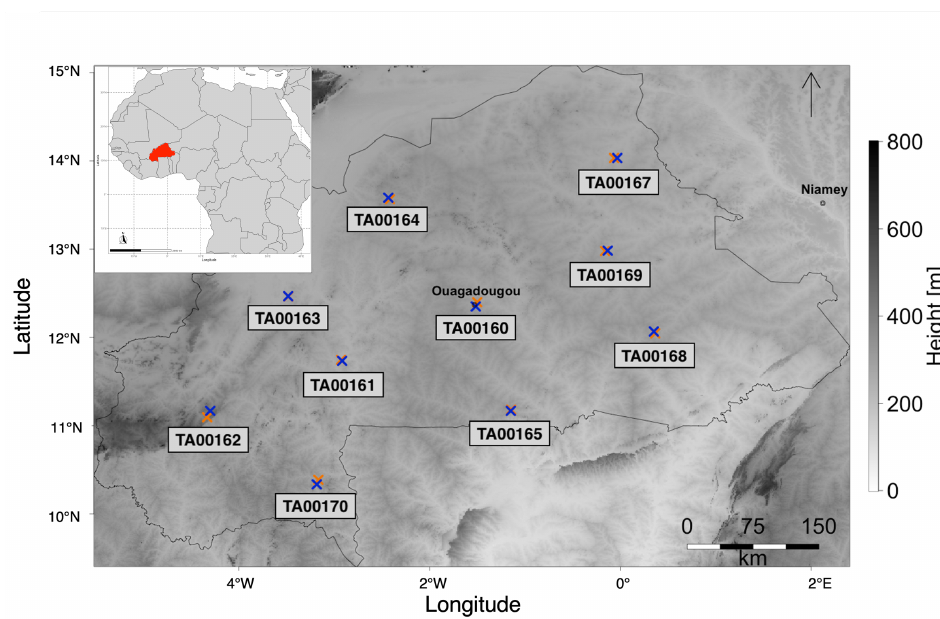
Figure 2. Topographic map from Burkina Faso with the examined stations and the TAHMO station name (for MET station name see Table 1). Stations from the Burkina Faso meteorological service are in blue, the TAHMO stations are highlighted in orange. The TAHMO stations with the largest distance to the reference MET station are in Ouagadougou, Bobo-Dioulasso and Gaoua. Exact distance values can be found in Table